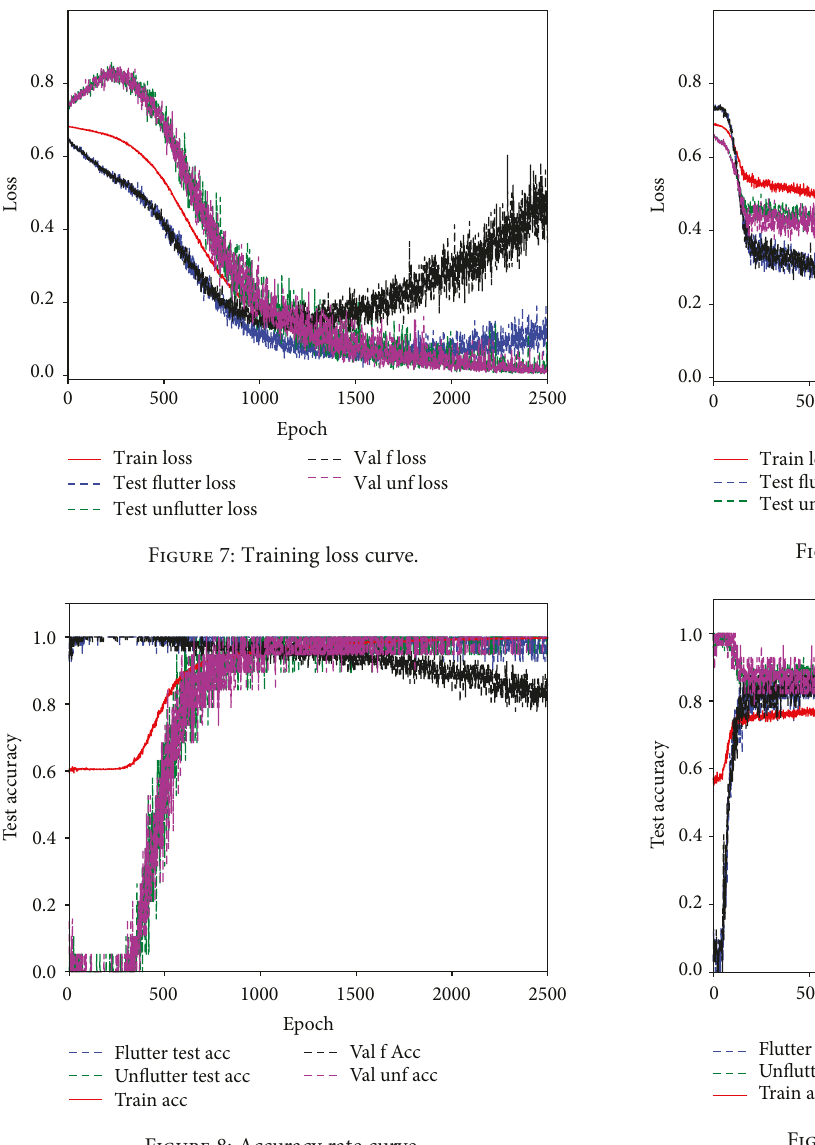
Figure 8: Accuracy rate curve.